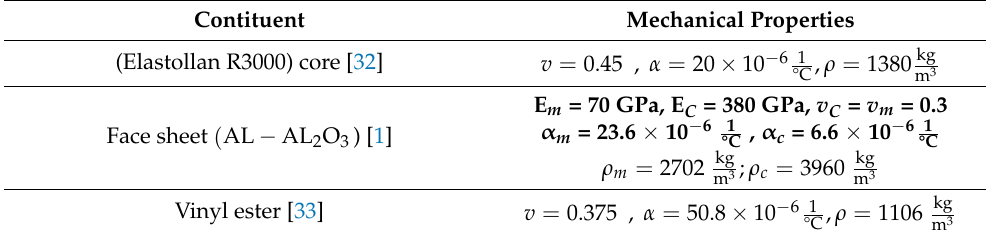
Table 7. The mechanical properties of the five-layer sandwich plate.